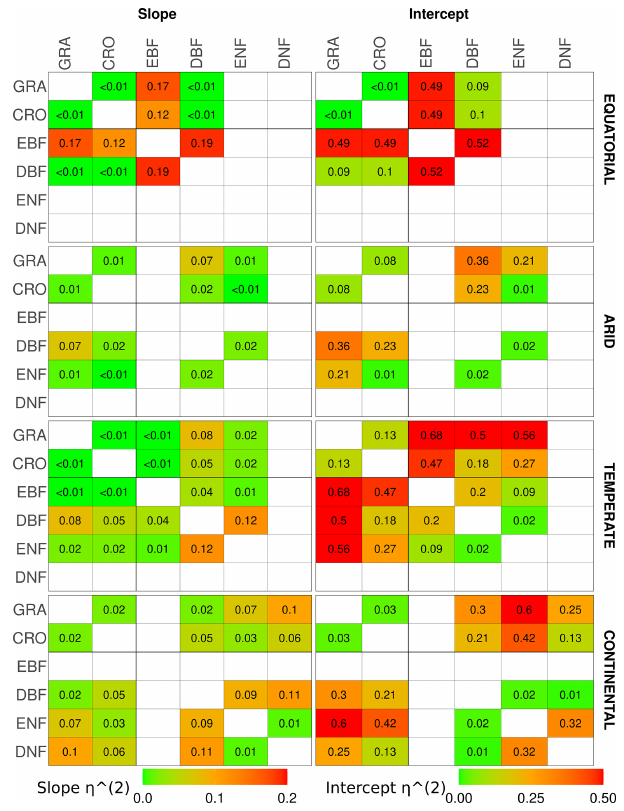
Figure 6. The η 2 parameter of an analysis of covariance be- tween pairs of vegetation covers in different Köppen–Geiger cli- mate groupings, for the slope (left) and intercept (right) of the linear relationship between downscaled SIF and FLUXCOM GPP. AN- COVA is performed on the intercept under the assumption that the difference between slopes is not significant. The η 2 parameter is comparable to the percentage of the difference in the slope or in- tercept (the latter assuming equivalence of the slopes) attributable to the difference in vegetation cover, with lower values signifying a smaller difference between vegetation covers. A slightly bolder line is used to separate the herbaceous species (CRO, GRA) from the woody species (EBF, DBF, ENF,